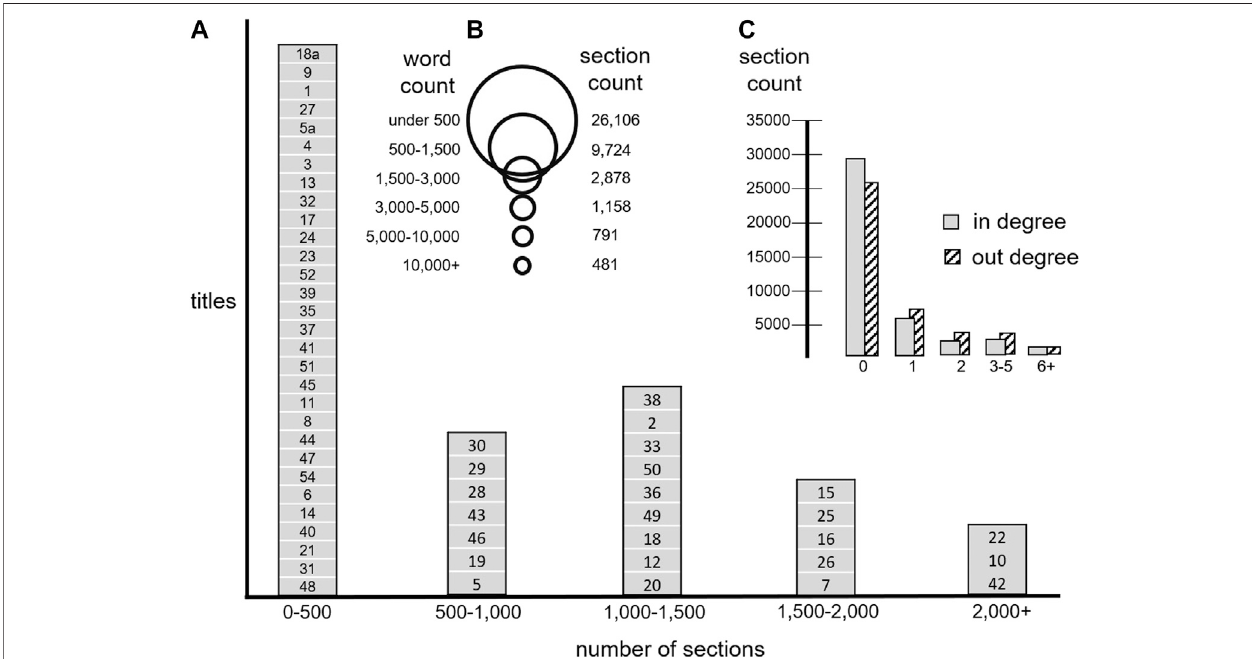
FIGURE 1 | The number of sections in each title varies considerably, and is right skewed. Panel (A) arranges each title from least to most sections and places the titles into four buckets. Title 18a has the smallest number of sections (17) and title 42 has the largest (4,581). There is also considerable variation in the word counts in each section, with a large number of fairly small sections (under 500 words) and a small number of very long sections (over 10,000 words). Panel (B) illustrates this variation. Panel (C) provides histograms of in-degree and out-degree for cross-references at the section